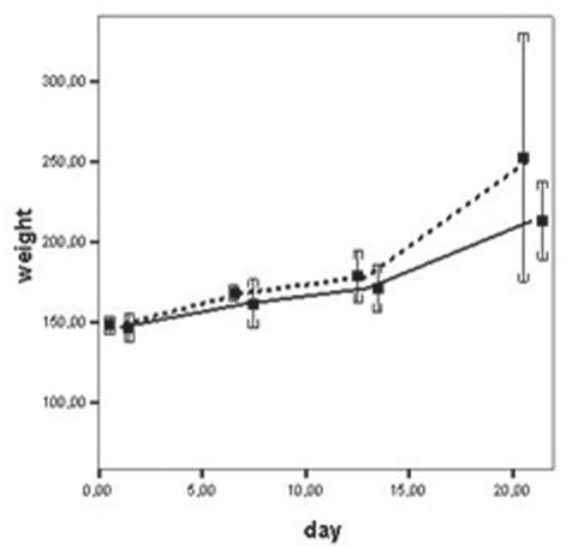
Figure 1. Evolution of rat body weight (g) following repetitive exposure to Buthus occitanus tunetanus venom or saline solution, from the 7 th to the 13 th day of pregnancy. No significant differences (Mann-Whitney tests) had been checked between venom treated rats (dotted line) and control ones (continuous